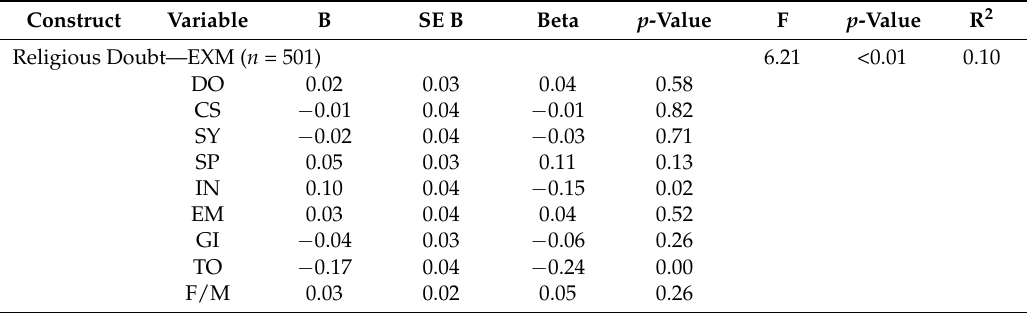
Table 2. Standard Multiple Regression Analyses for the Influence of Social Personality Traits on Religious Doubt